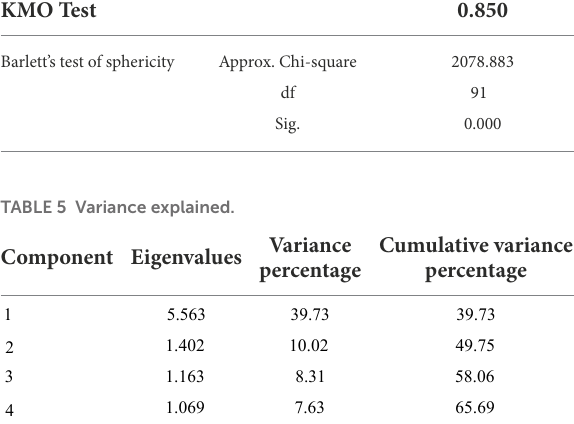
TABLE 6 Component matrix.